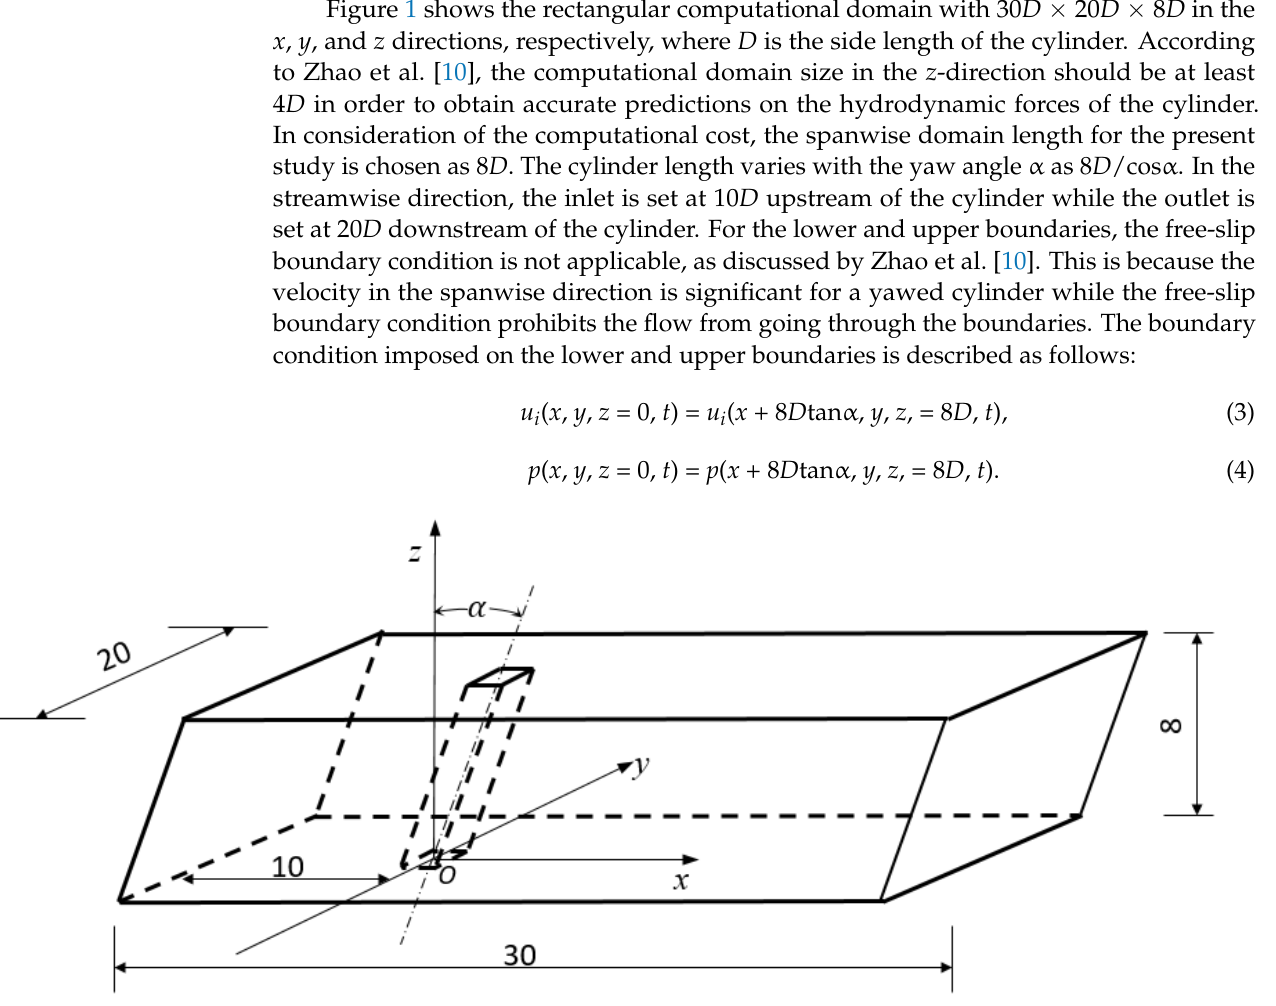
Figure 1. Schematic diagram of the coordinate and the computational domain (unit in D ).